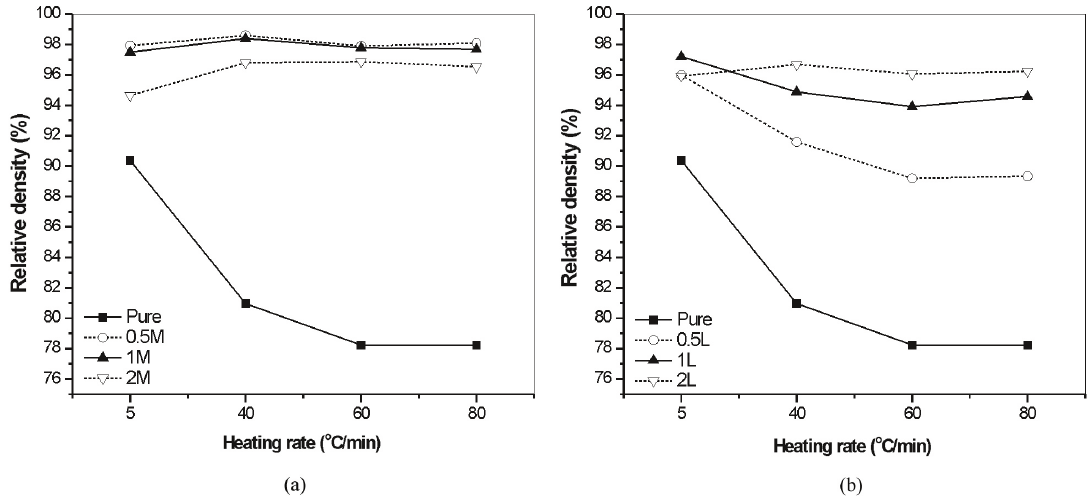
Figure 2. Relative density of fast sintered samples: a) MgO doped, and b) La